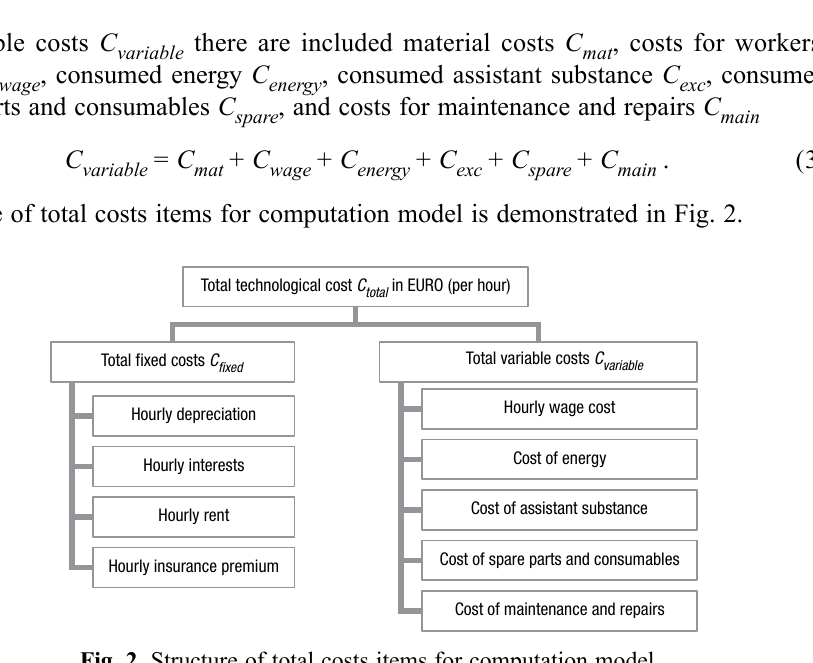
Fig. 2. Structure of total costs items for computation model